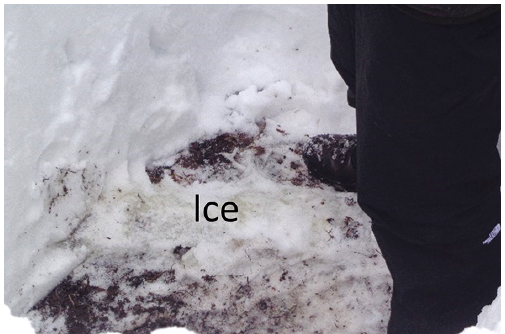
Figure 5. Picture of frozen ice “vein” observed at the snow–soil interface (SSI) providing evidence of lateral flow of meltwater oc- curring within the snowpack. Foot shown for